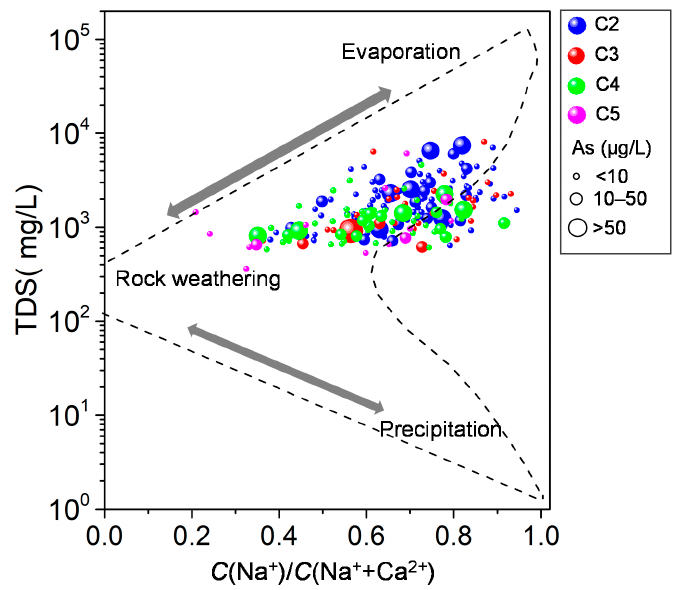
Figure 9. Gibbs diagram of the groundwater samples in the study area.